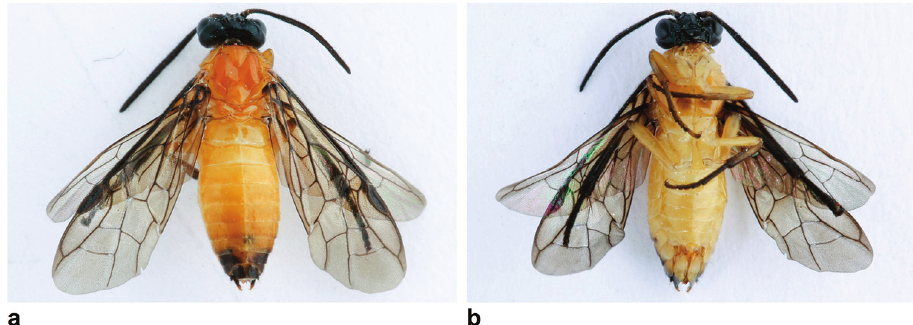
Figure 6. Scobina notaticollis , female (P4213), body length 7.5 mm. a Dorsal view b ventral